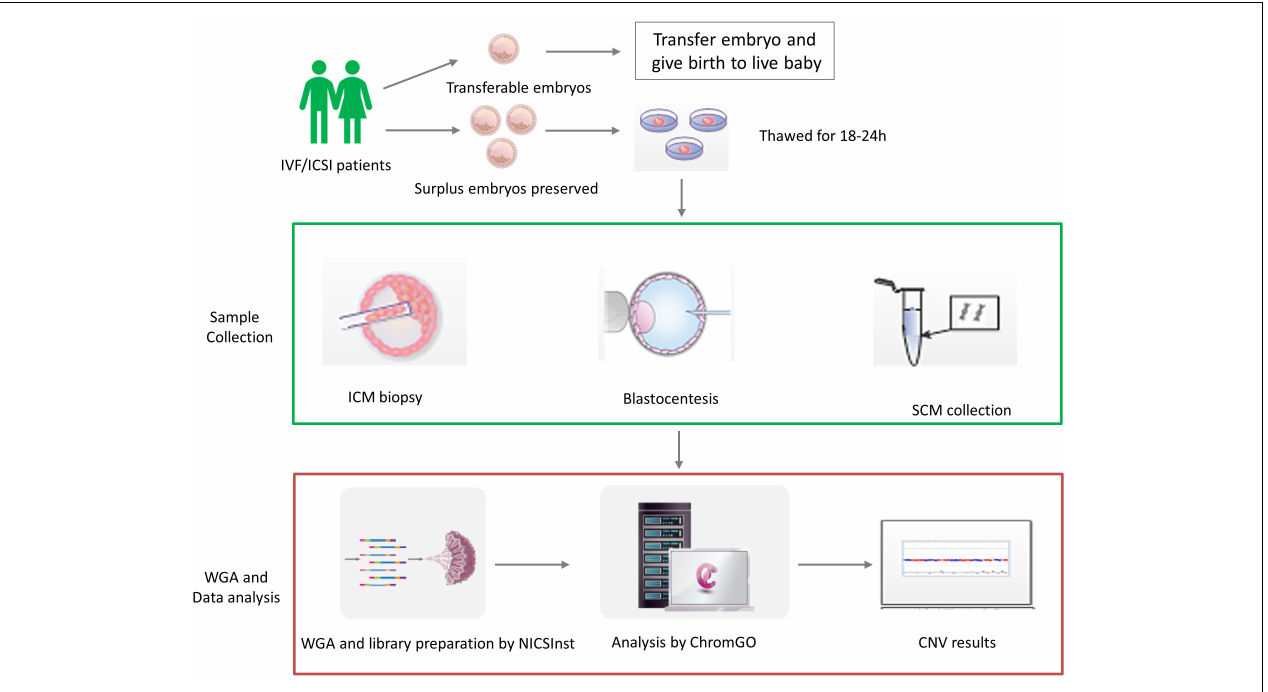
FIGURE 1 | The validation procedure of the study design. Human blastocysts were donated by in vitro fertilization (IVF)/intracytoplasmic sperm injection (ICSI) patients with preserved surplus embryos after giving birth to live healthy babies. We then validated non-invasive chromosome screening (NICS) using spent culture medium (SCM) versus blastocoel fluid (BF) as a source of DNA. In each embryo, we obtained the chromosome ploidy results from the inner cell mass (ICM), trophectoderm biopsy (TE), SCM, and BF after whole-genome amplification (WGA) and library preparation by NICSInst. Copy number variation (CNV) was determined by ChromGo Analysis